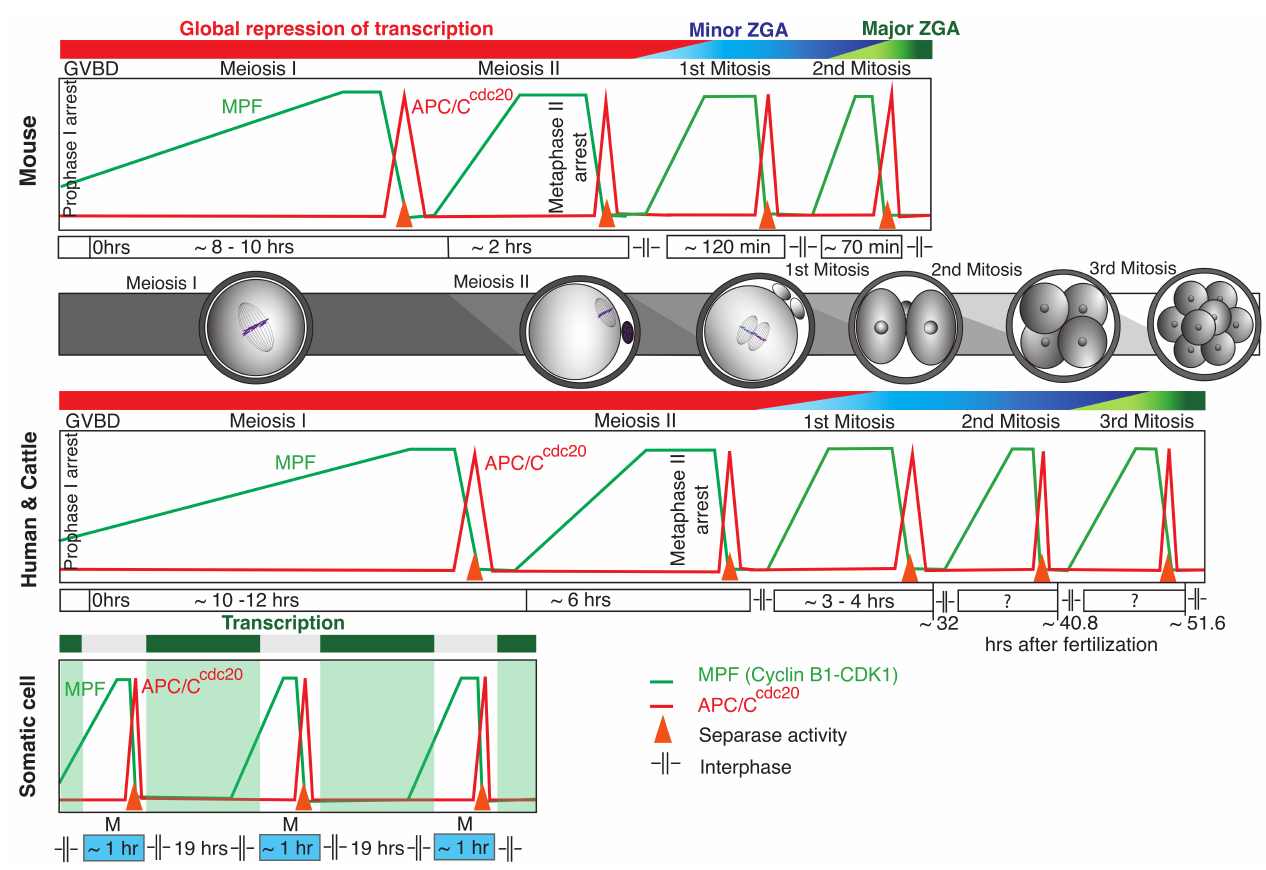
Figure 1. The differences in the utilization of transcription for cell cycle regulation between mouse, human and cattle oocytes and early embryos (upper and middle panel) and somatic cells (lower panel). The relative duration of the cell cycle stages and timing of the activity of MPF, APC/C and separase are indicated. Whereas, in oocytes, transcription is silenced in fully grown oocytes and then restarted during the minor and major waves of ZGA, somatic cells have the ability to replenish major cell cycle regulators by transcription during the interphase. The execution of cell cycles during early development is therefore fully dependent on the regulated translation of transcripts accumulated at the GV stage. In the case of proteins that are targeted during each anaphase, such as cyclin B, a controlled translation is crucial. Information from the following publications was used for the figure preparation: references